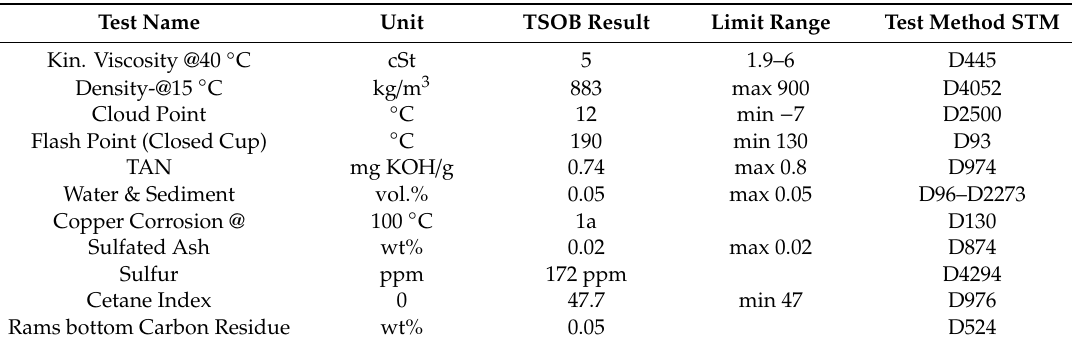
Table 1. TSOB specifications according to ASTM standard.